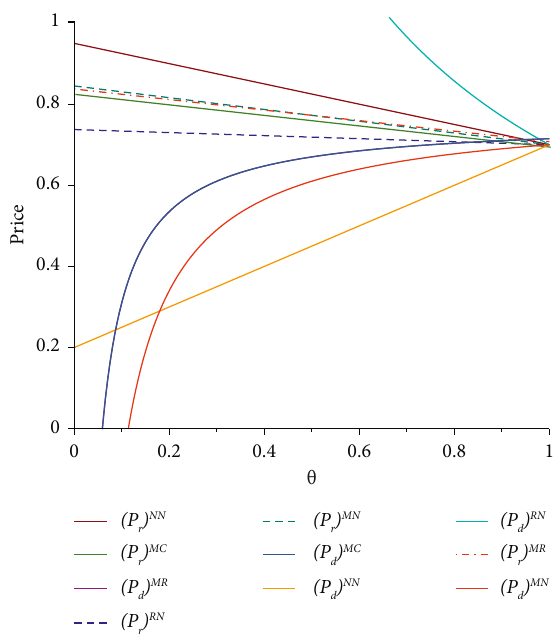
Figure 1: Effect of θ on optimal price.